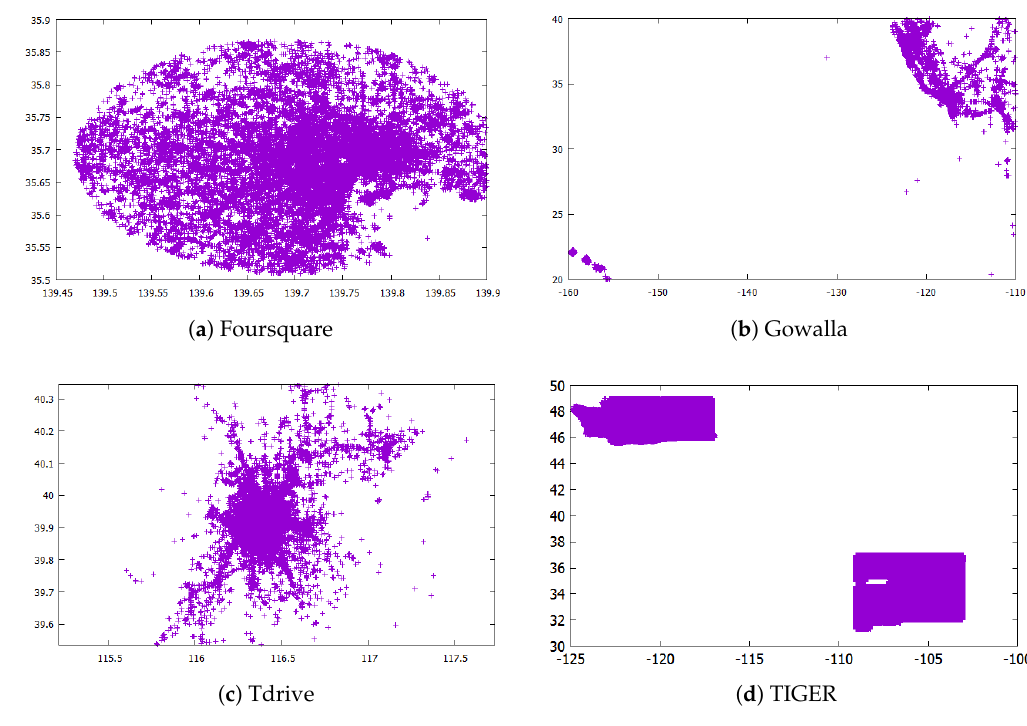
Figure 9. Illustration of